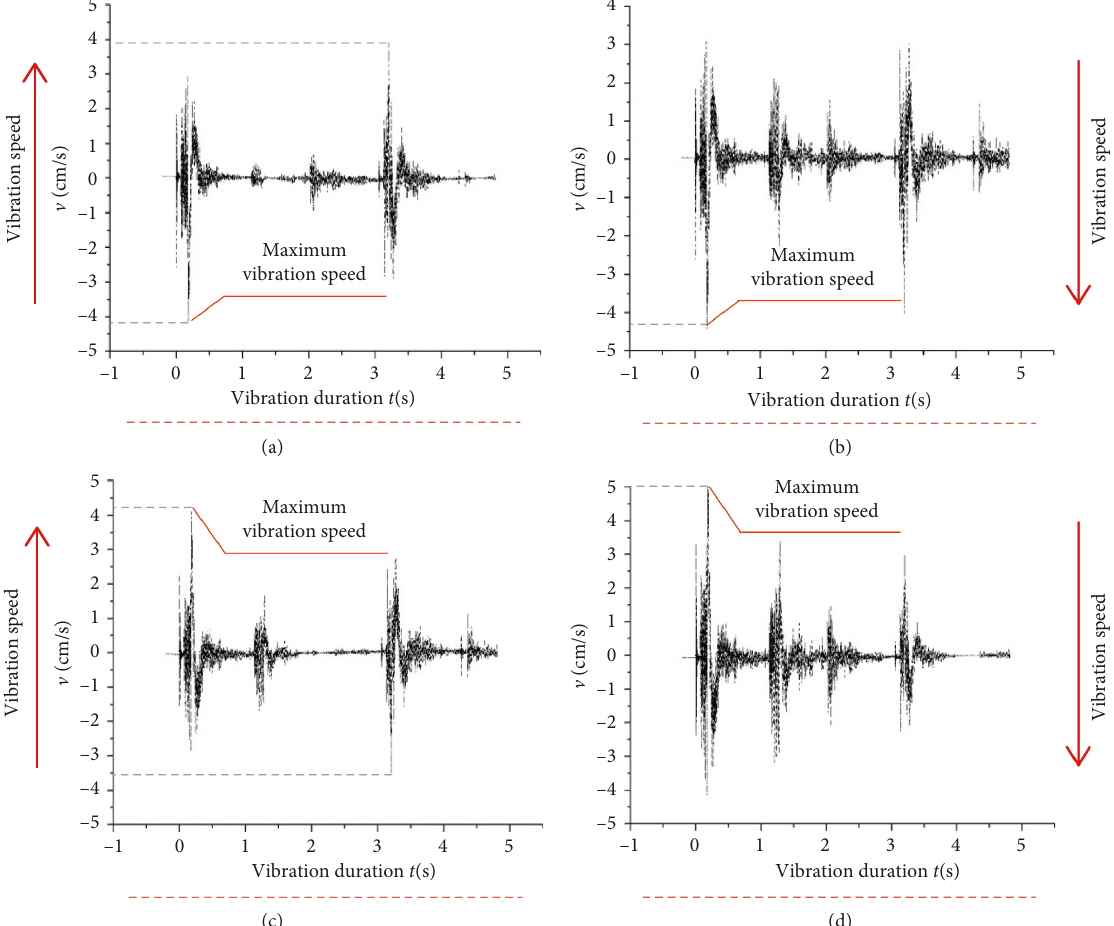
Figure 17: Burst disturbance waveform. The velocity waveforms produced by blasting of 32kg, 40kg, 48kg, and 60 kg explosives are represented, and the main frequency is 74 Hz, 3.7Hz, 96 Hz, and 4.5Hz, respectively. (a) Explosive content 32kg and main vibration frequency 74Hz. (b) Explosive content 40kg and main vibration frequency 3.7 Hz. (c) Explosive content 48kg and main vibration frequency 96Hz. (d) Explosive content 60kg and main vibration frequency